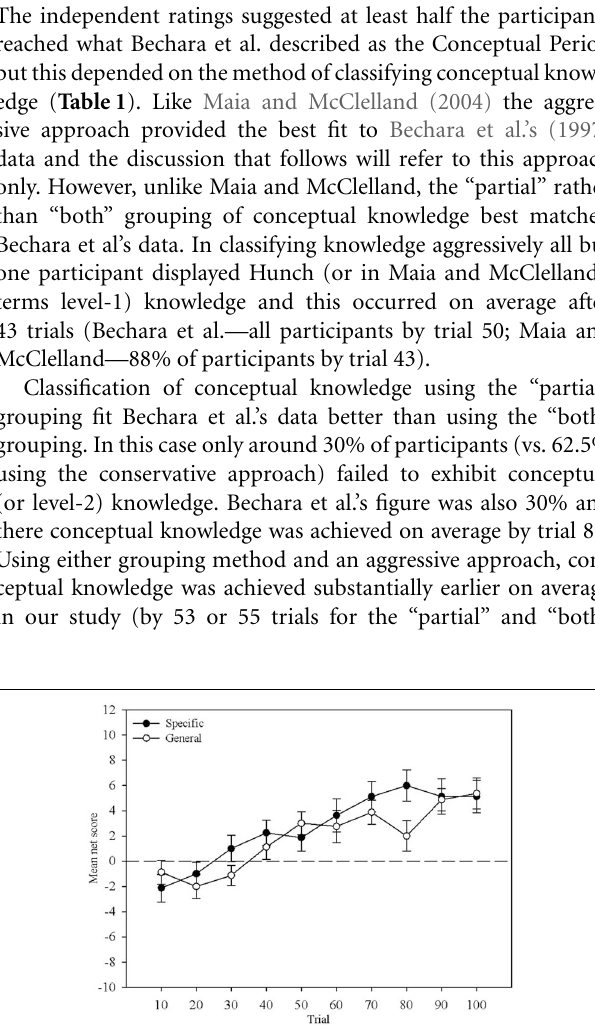
FIGURE 1 | Mean net score across 10-trial blocks. The closed circles represent the Specific question group and the open circles represent the General question group. Error bars are the standard error of the